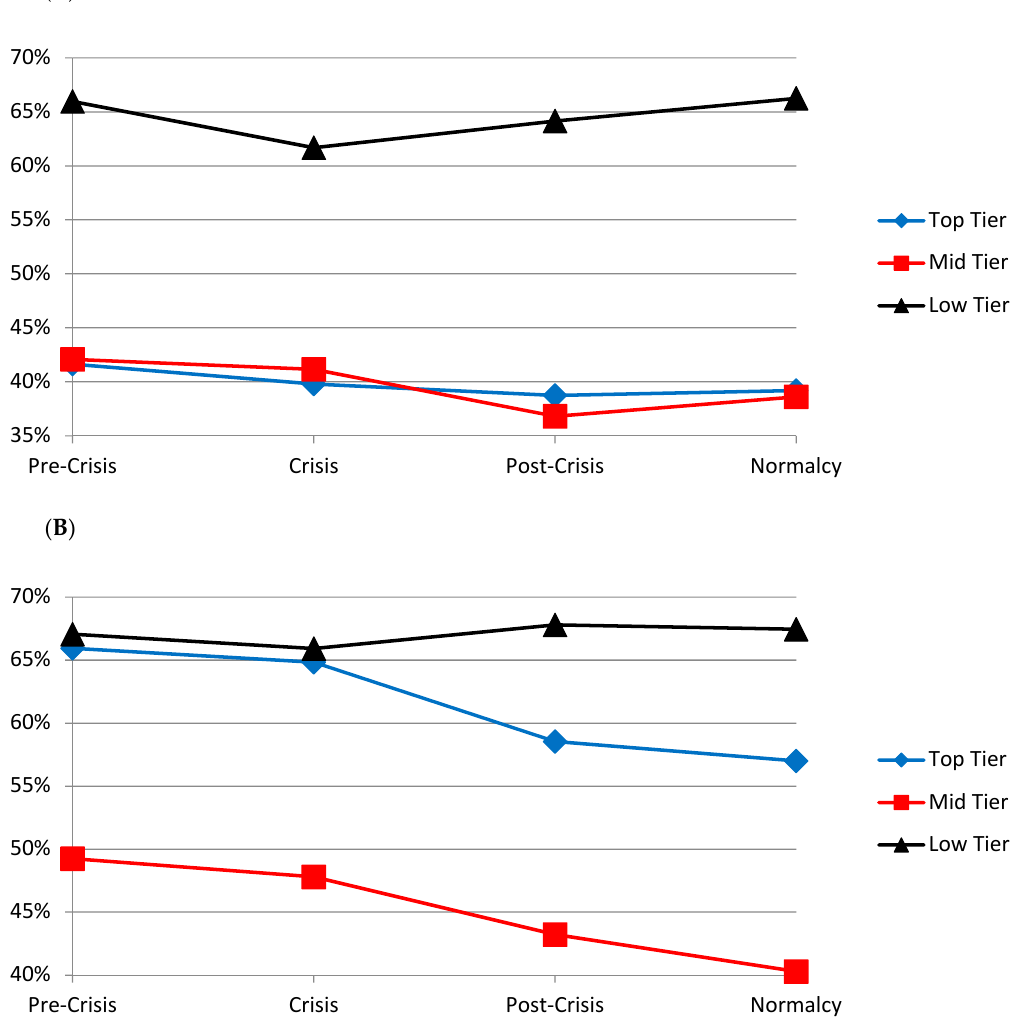
Figure 5. ( A ) Loans/Total Assets Ratio. ( B ) Interest Income/Total Income Ratio. Notes: Top-Tier: JPMorgan Chase, Bank of America, Citigroup, and Wells Fargo; Mid-tier: Bank of New York Mellon, State Street, US Bancorp, and PNC Financial Services Group; Low-tier: Capital One Financial, BB&T, SunTrust Banks, and Regions Financial. Pre-crisis: 2005–2007; Crisis: 2008–2010; Post-Crisis: 2011–2013; Normalcy: 2014–2016. Data obtained from published financial reports.